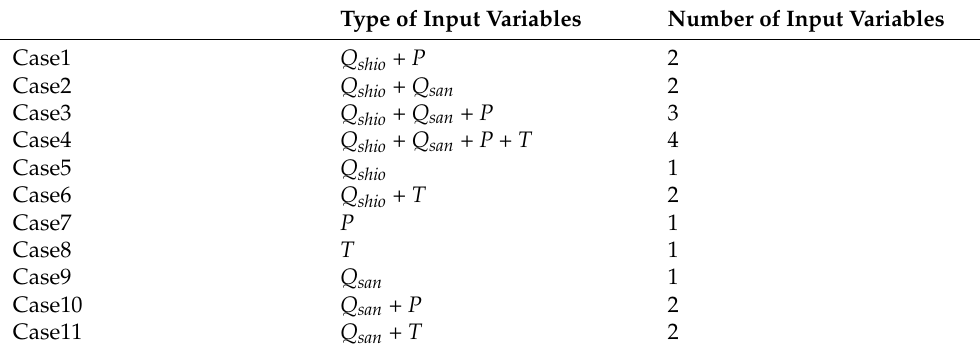
Table 2. Cases of input